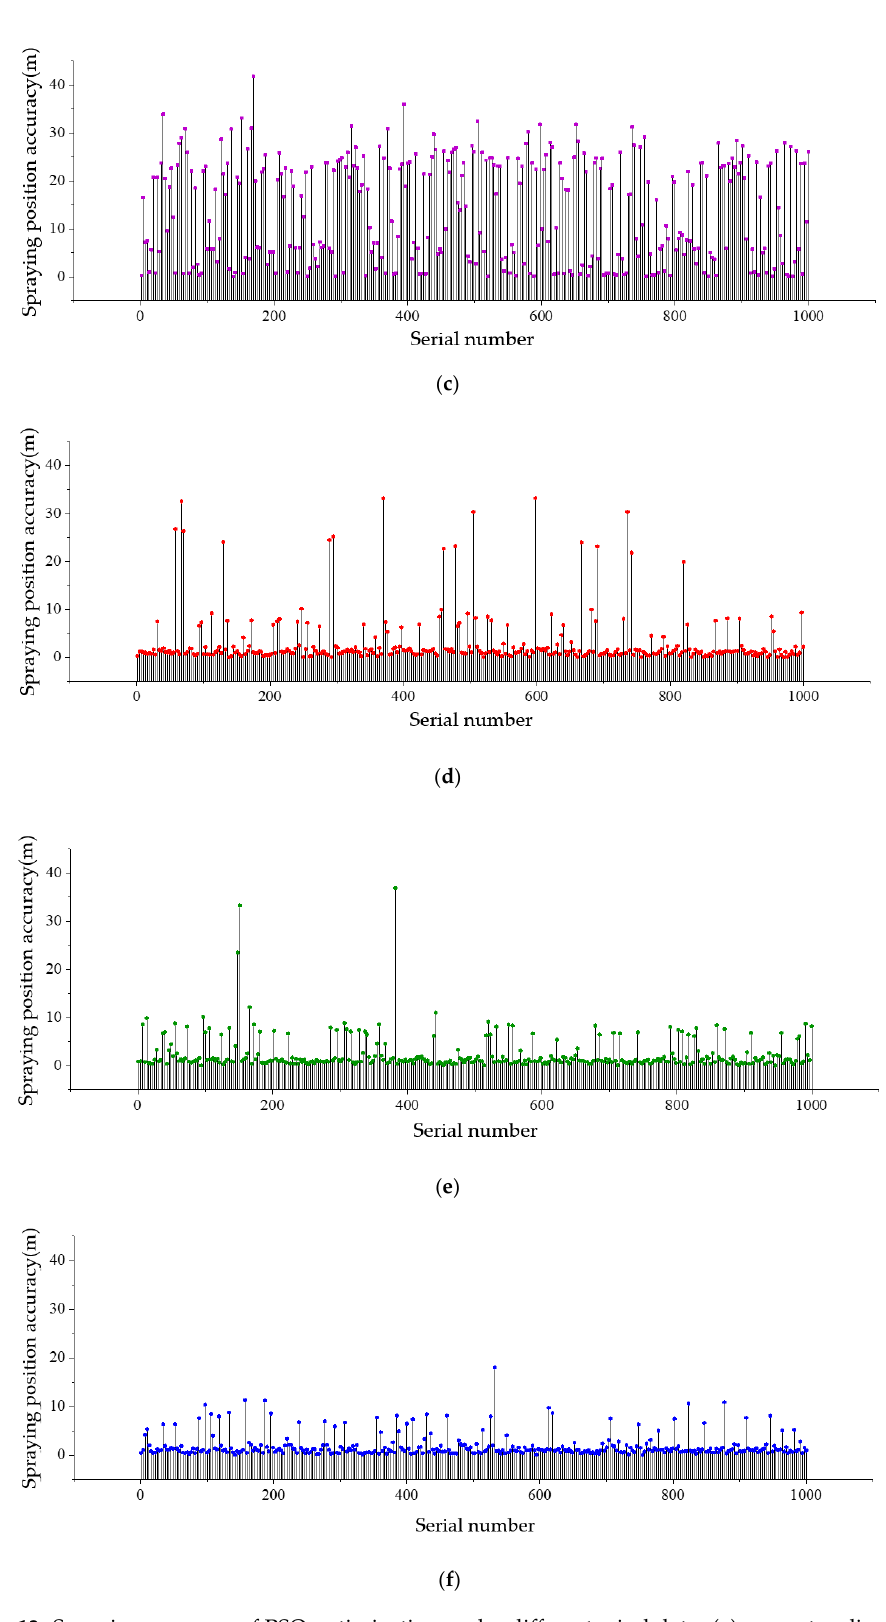
Figure 13. Spraying accuracy of PSO optimization under different wind data. ( a ) no route adjustment; ( b ) route adjustment with current wind data; ( c ) route adjustment with predicted wind data; ( d ) route adjustment with combined wind data (W = 0.35 m/s); ( e ) route adjustment with combined wind data (W = 0.5 m/s); ( f ) route adjustment with combined wind data (W = 1 m/s). The average spraying accuracy by using different wind speed and direction data in the DQN and PSO trajectory optimization is presented in Table 5. The average spraying accuracy f ̅ is obtained upon the test of 1000 sets of data. It can be seen that trajectory optimization using the combined wind data of the current and the predicted with the threshold of 1 m/s present a slightly improved effect, in comparison to the trajectory optimization using merely the current wind direction and speed data. It is because predicting the wind data of the next time period based on the recent changes in wind speed and direction can capture some changing trend of wind in the case of great changes happening, which is more effective than merely using the current wind speed and direction to replace the future wind speed and direction. Table 5. Average spraying accuracy under different wind data. Settings